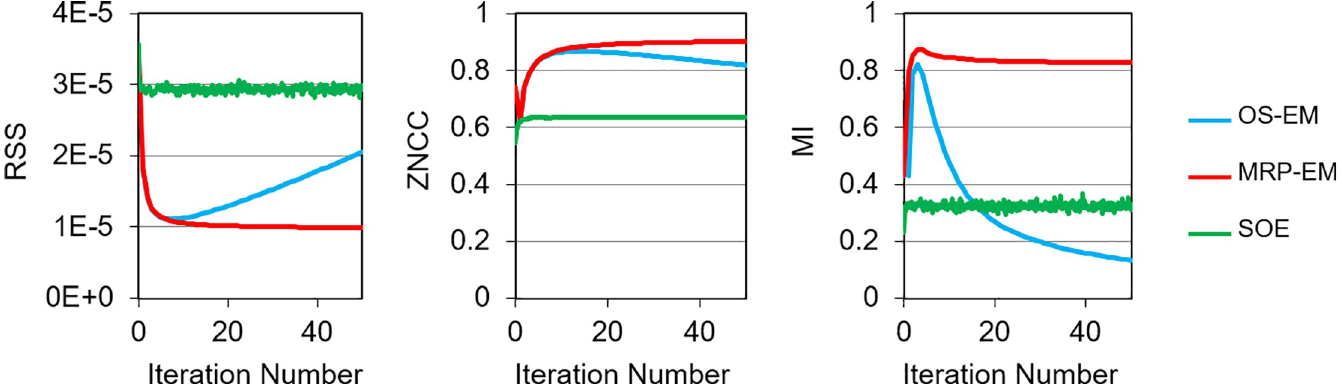
Fig 5. Changes in RSS, ZNCC, and MI of the reconstructed image for each iterative algorithm (OS-EM: blue, MRP-EM: red and SOE: green). Lower values are preferable for RSS, and higher values are better for ZNCC and MI. The x-axis value (iteration number) of SOE is 10 times greater than that of OS-EM and MRP-EM. The RSS, ZNCC, and MI values of BP were 2.8 × 10 − 5 , 0.35, and 0.43, respectively, and those of the analytical method were 2.0 × 10 − 5 , 0.88, and 0.76, respectively.